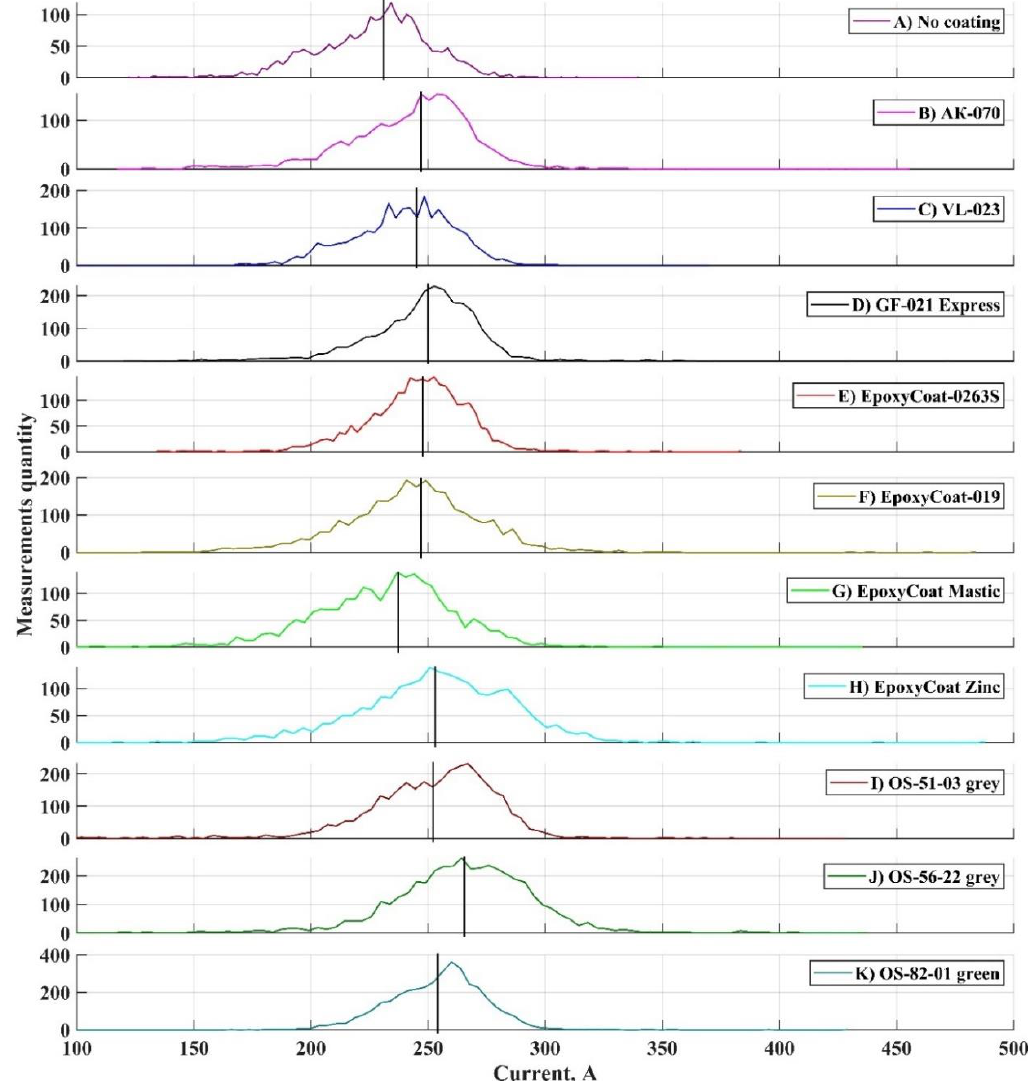
Figure 6. Profiles of mean arc current histograms: ( A ) No coating; ( B ) AK-070; ( C ) VL-023; ( D ) GF-021 Express; ( E ) EpoxyCoat-0263S; ( F ) EpoxyCoat-019; ( G ) EpoxyCoat Mastic; ( H ) EpoxyCoat Zinc; ( I ) OS-51-03 grey; ( J ) OS-56-22 grey; ( K ) OS-82-01 green.